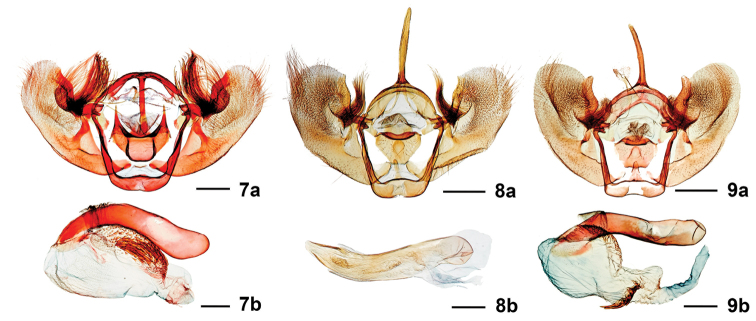
Male genitalia. 7Stamnodes
fergusoni (USNM58902), a genital capsule, b aedeagus with everted vesica; 8Stamnodes
fervefactaria (USNM55242), a genital capsule, b aedeagus; 9Stamnodes
deceptiva (USNM58903), a genital capsule, b aedeagus with everted vesica. Scale bars: 0.85 mm (9a), 0.25 mm (9b).